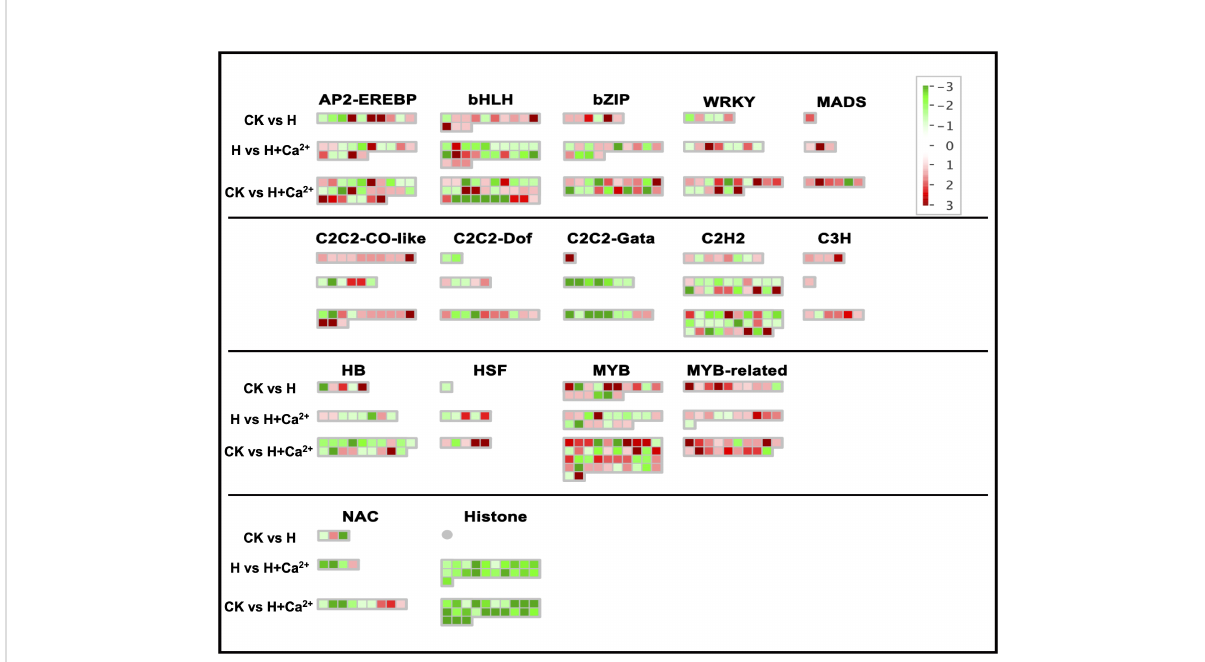
FIGURE 5 Display of gene expression of transcription factors. Signi fi cantly DEGs (log2 fold changes (FC) ≥ 1, FDR ≤ 0.05) were visualized using Mapman software and organized into functional categories (BINs). Green indicates a decrease and red an increase in gene expression (see color set scale on top right corner). Detailed information on each gene and its expression level is listed in Supplementary Table S4.